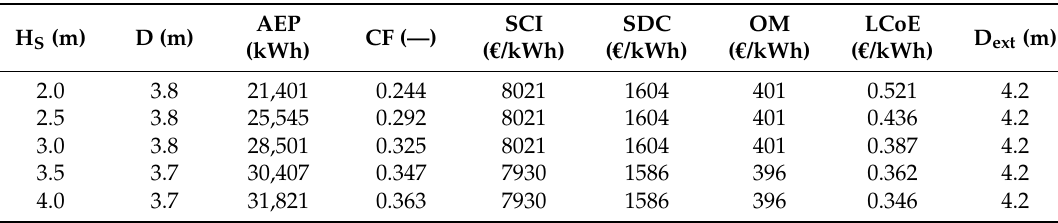
Table 11. Incidence of maximum significant wave height on main data of WEC devices with the fully submerged mass at